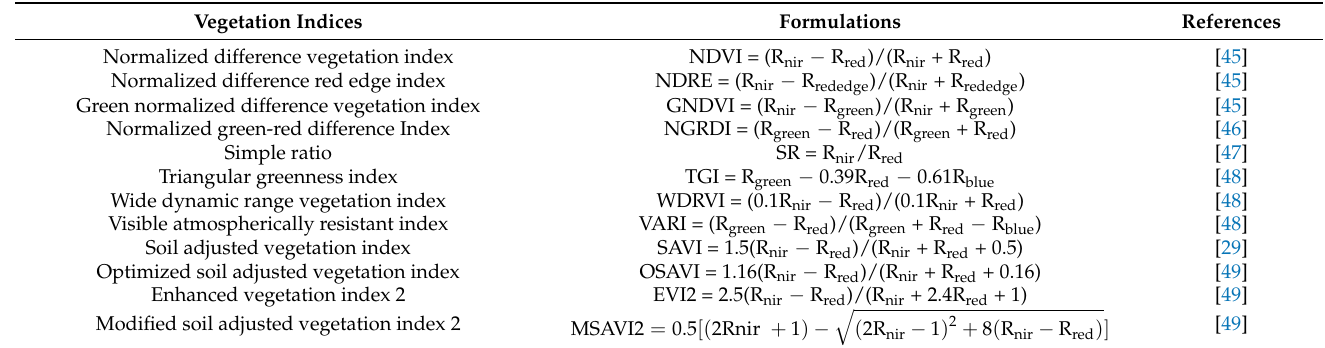
Table 2. Formulations and references of the selected vegetation indices in this